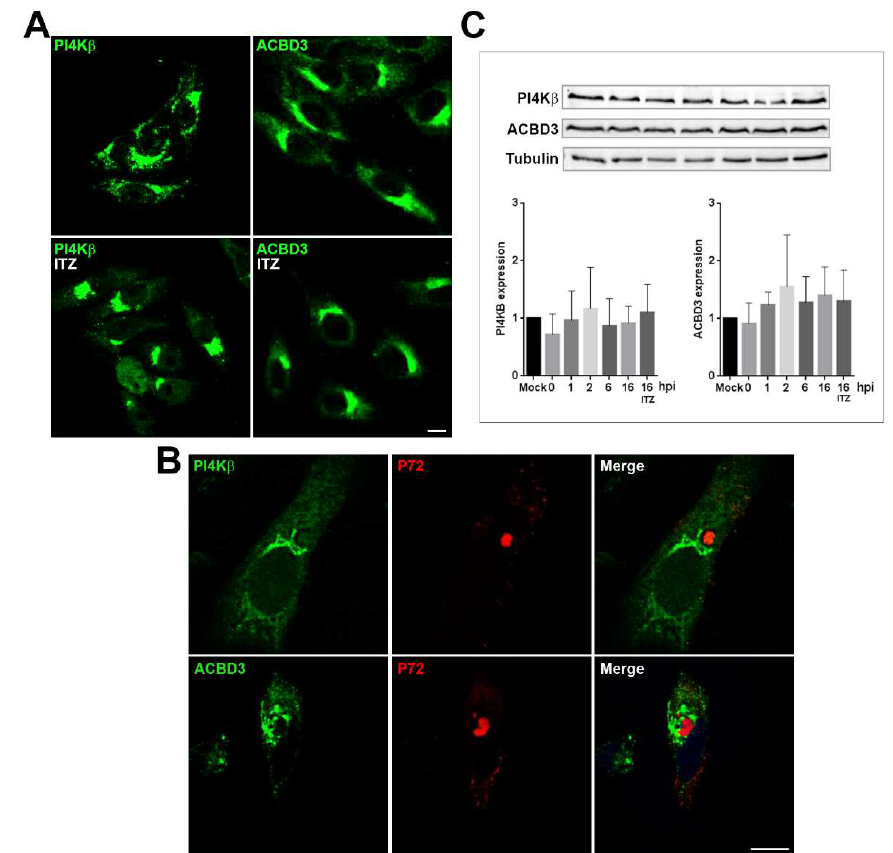
Figure 6. OSBP-related proteins PI4Kβ and ACBD3 redistribute to areas around VFs. ( A ) Mock- or infected Vero cells treated with ITZ or DMSO or ( B ) infected with ASFV for 16 h and stained for ACBD3 or PI4Kβ (green). Infected cells were labelled for viral protein p72 (red). PI4Kβ distributed around the VF, leaving a ring devoid of staining around the replication organelle. ACBD3 was redistributed and accumulated at the VFs and presented a vesicular staining. Bar 10 μm. ( C ) Graphs show PI4Kβ and ACBD3 expression at several times postinfection (1–16 hpi) and under ITZ treatment at 16 hpi. Quantification of the bands was corrected to tubulin data and normalized to control (mock) values. A representative WB image is shown.